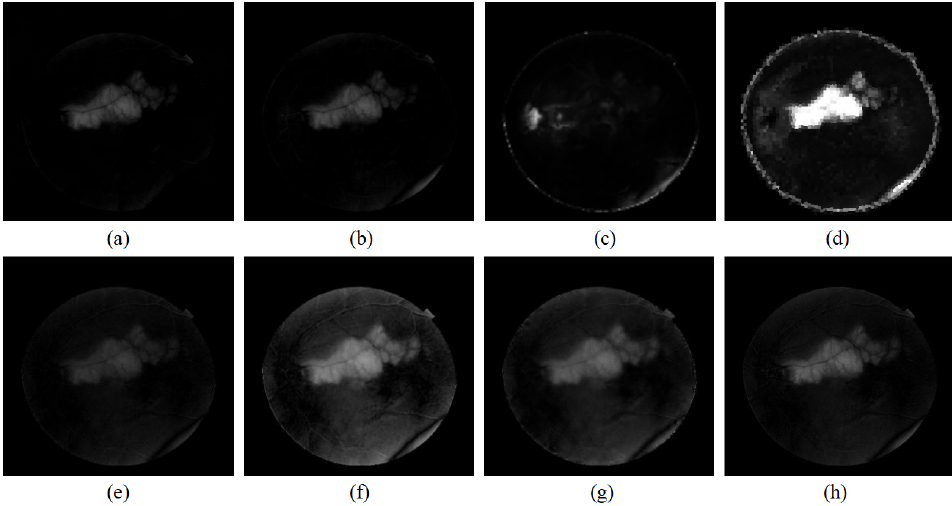
Figure 11. Detected change region for the image pair with the big lesion in Figure 4. ( a ) P-RPCA; ( b ) RPCA; ( c ) NPSG; ( d ) IRG-McS; ( e ) logarithmic quotient; ( f ) mean difference; ( g ) wavelet fusion; and ( h ) IRHSF